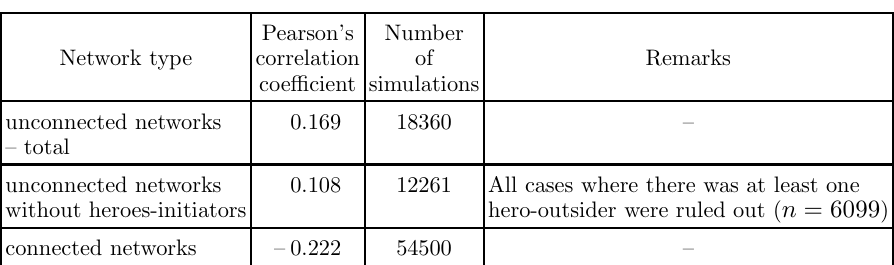
Correlations between network density and the range of diffusion for connected and unconnected